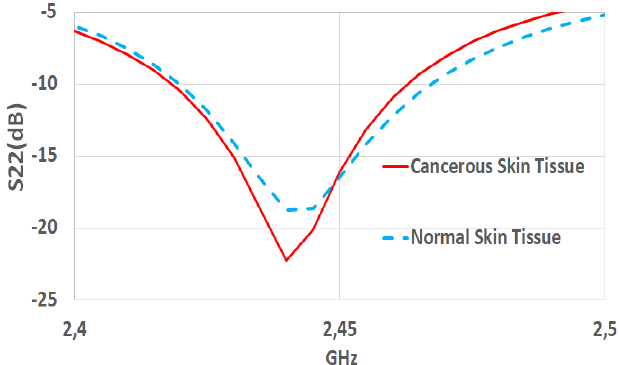
Figure 10: Differences of S 22 values between cancerous and normal tissue obtained from the experimental